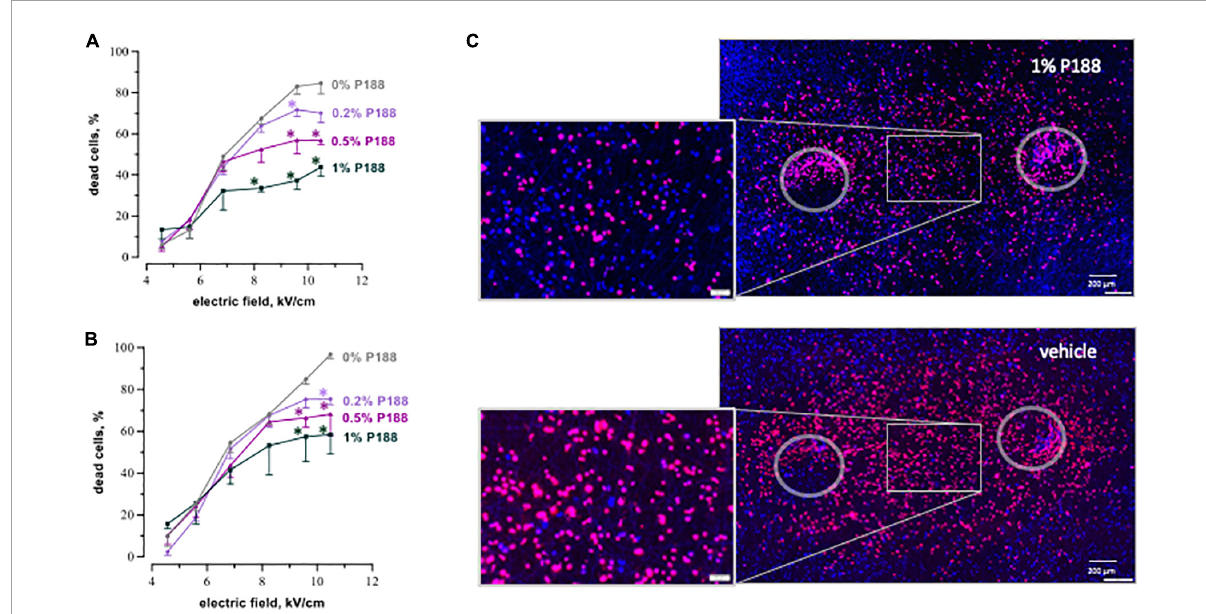
FIGURE5 P188 reduces cardiac cell death after nsPEF shocks. The plots display the percent of dead cells at 4 h (A) and 8 h (B) after exposure to 200, 300-nsPEF shocks at 10 Hz. Poloxamer 188 (P188) was added at indicated concentrations (0% is vehicle control) 10 s after the end of nsPEF shocks exposure. Mean ± SEM, 3–5 independent experiments for each P188 concentration. * p < 0.05 for the difference between vehicle and P188 at the same electric field strength. Fluorescence images of cell monolayers (C) were taken at 8 h after exposure to nsPEF shocks followed in 10 s by either 1% P188 or vehicle. Selected areas are magnified in the insets. Note a profound reduction of cell death in samples treated with P188. See Figure 3 for more details.